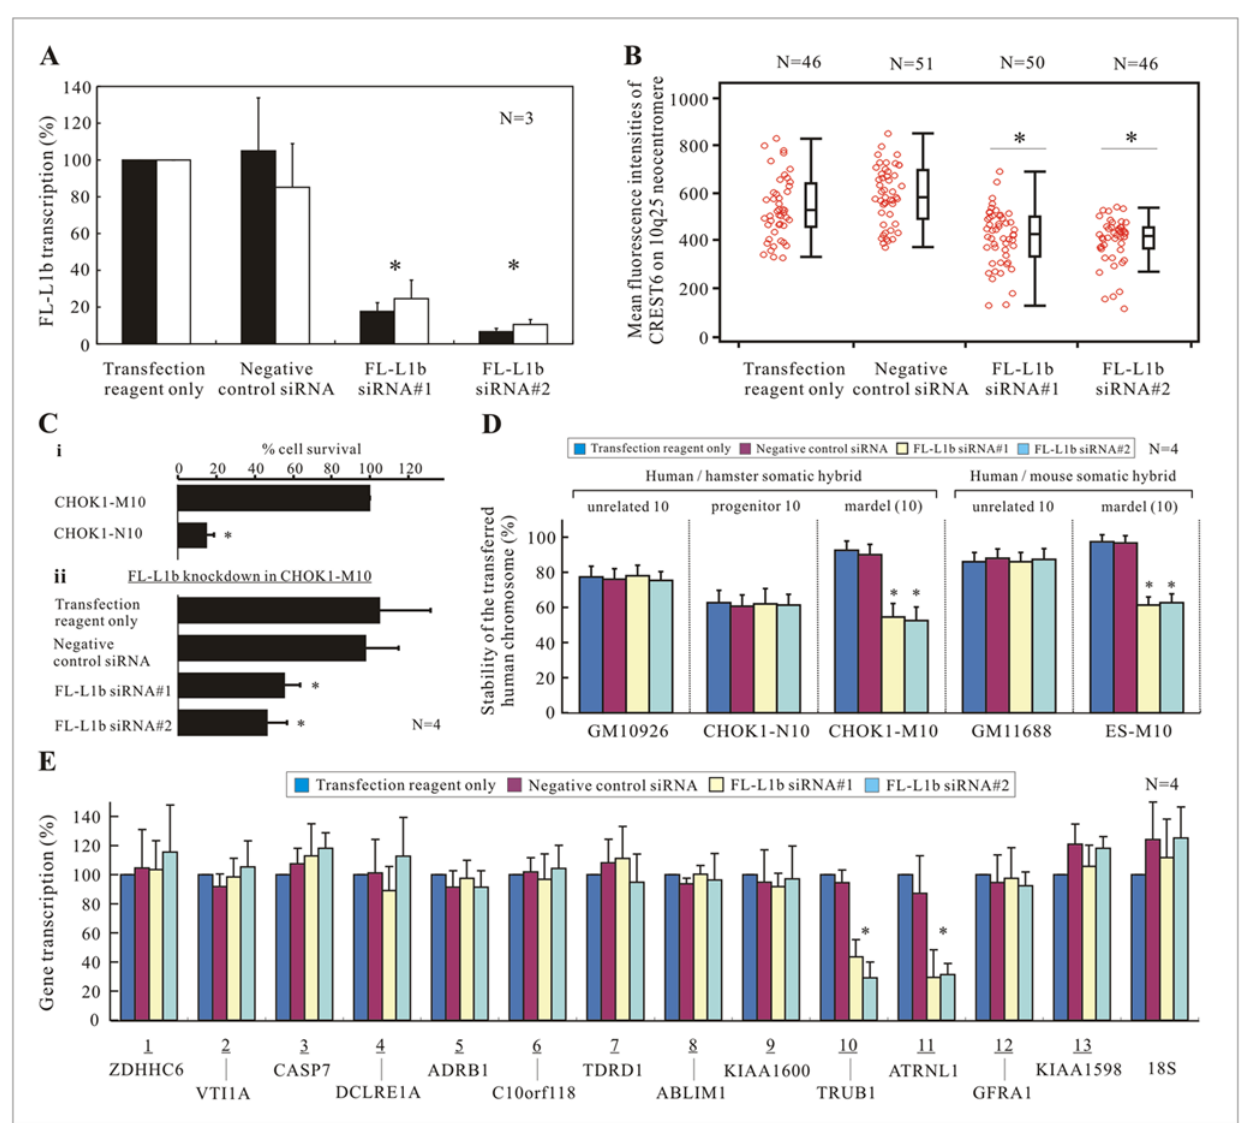
Figure 4. Transcriptional knockdown of FL-L1b and its associated effects on neocentromere structure and function. (A) Efficient RNAi knockdown of FL-L1b in CHOK1-M10. CHOK1-M10 cells were transfected with FL-L1b-specific siRNA oligonucleotide duplexes, FL-L1b siRNA # 1 and siRNA # 2, at a final concentration of 25 nM. Following 48 hours post transfection, FL-L1b RNA levels were assayed by quantitative RT-PCR analysis using primer sets FL-L1b.1 (black bars) and FL-L1b.3 (white bars). Both siRNA duplexes effectively knocked-down the transcription level of FL-L1b ( P , 0.05, indicated by the asterisks) by . 80% (mean for n=3, with SEM), compared to the transfection-reagent-only and Stealth siRNA low GC negative controls. (B) The structural integrity of 10q25 neocentromere in CHOK1-M10 cells after 24 hours post siRNA transfection was investigated by dual immunofluorescence/FISH analysis using an anti-CENP-A antiserum (CREST6) and a BAC probe (RP11-359H22) specific for the 10q25 neocentromeric region of mardel(10). After FL-L1b knockdown, the mean fluorescence intensity of CREST6 at 10q25 neocentromere was significantly reduced (by 20–30%; P , 0.001, indicated by the asterisks). Each spot in the combined scatter/box plot represented the relative amount of CENP-A protein at 10q25 neocentromere in one metaphase spread, which was calculated by an average of 5 measurements normalized against the average signals on 15–20 CHO centromeres within each spread. (C) Zeocin kill-curve analysis. (i) Addition of 200 m g/ml Zeocin effectively killed CHOK1-N10 cells but did not affect the growth of CHOK1-M10 cells (n=4, with SEM); CHOK1-M10 cells were resistant to Zeocin because the mardel(10) chromosome had been tagged with a Zeocin resistance gene. The majority of the CHOK1-N10 cells ( . 80%; P , 0.05) were killed by 48 hours post Zeocin selection (n=4, with SEM). % cell survival=total cell number under Zeocin selection/total cell number without Zeocin selection. (ii) A 40–50% reduction in cell viability (mean for n=4, with SEM) was observed following knockdown of FL-L1b RNA and 48 hours of Zeocin selection. The differences in the % of cell survival in the L1b knockdown samples were statistically significant ( P , 0.05; indicated by the asterisks). (D) The stability of the neocentromeric mardel(10) chromosome or normal human chromosome 10 in the various hybrid cell lines was calculated as a percentage of the total number of cells containing a positive FISH signal of BAC RP11-359H22 after 48 hours of RNAi knockdown. FL-L1b transcription knockdown resulted in significantly reduced stability of the mardel(10) chromosome (mean for n=4, with SEM) but not of the normal human chromosome 10 in both the hamster and mouse hybrid cell lines ( P , 0.01; indicated by the asterisks). (E) Quantitative RT-PCR analysis of 13 genes found within or surrounding the 10q25 neocentromeric chromatin (see Figure 2A) in CHOK1-M10 was carried out 24 hours post FL-L1b RNA knockdown. While most of the genes were unaffected, the transcriptional activities of 2 neighboring genes, TRUB1 and ATRNL1 (mean for n=4, with SEM), were significantly reduced (by 60–70%; P , 0.05, indicated by the asterisks).